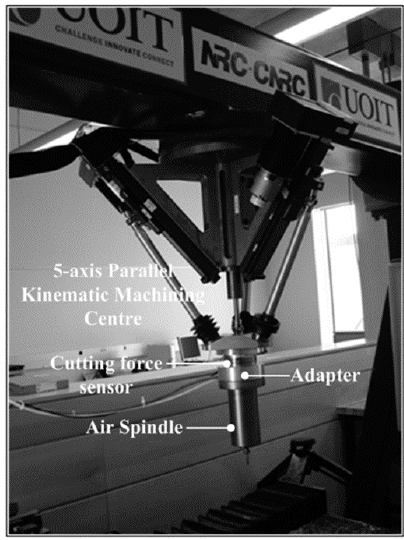
Figure 1. Experimental setup for implementing the sensor system for cutting force measurement.